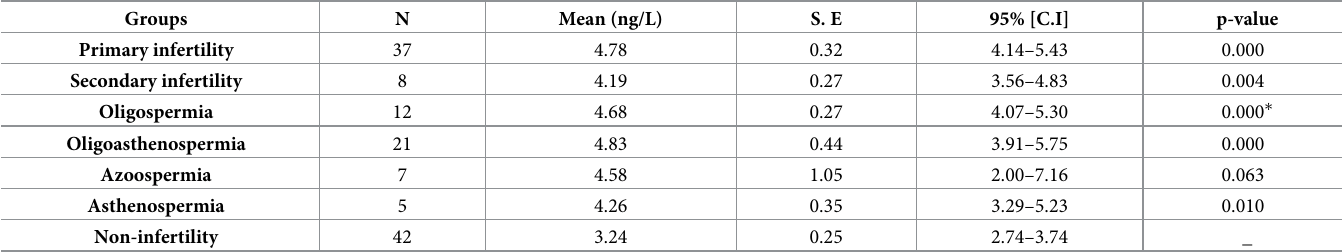
Table 4. Status of IL-1 β indifferent types of male infertility.